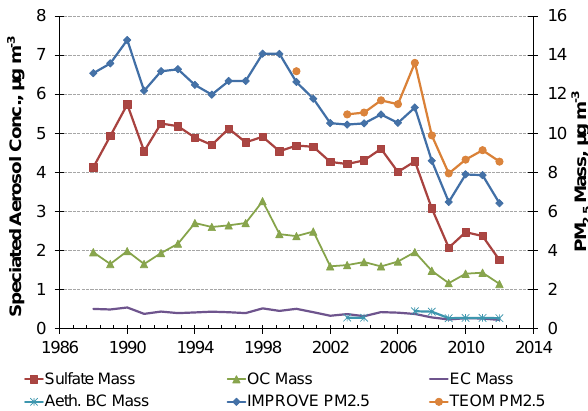
Figure 6. Trends in annual average IMPROVE PM 2 . 5 mass, sulfate, NH + , OC, EC, and BC at Look 4